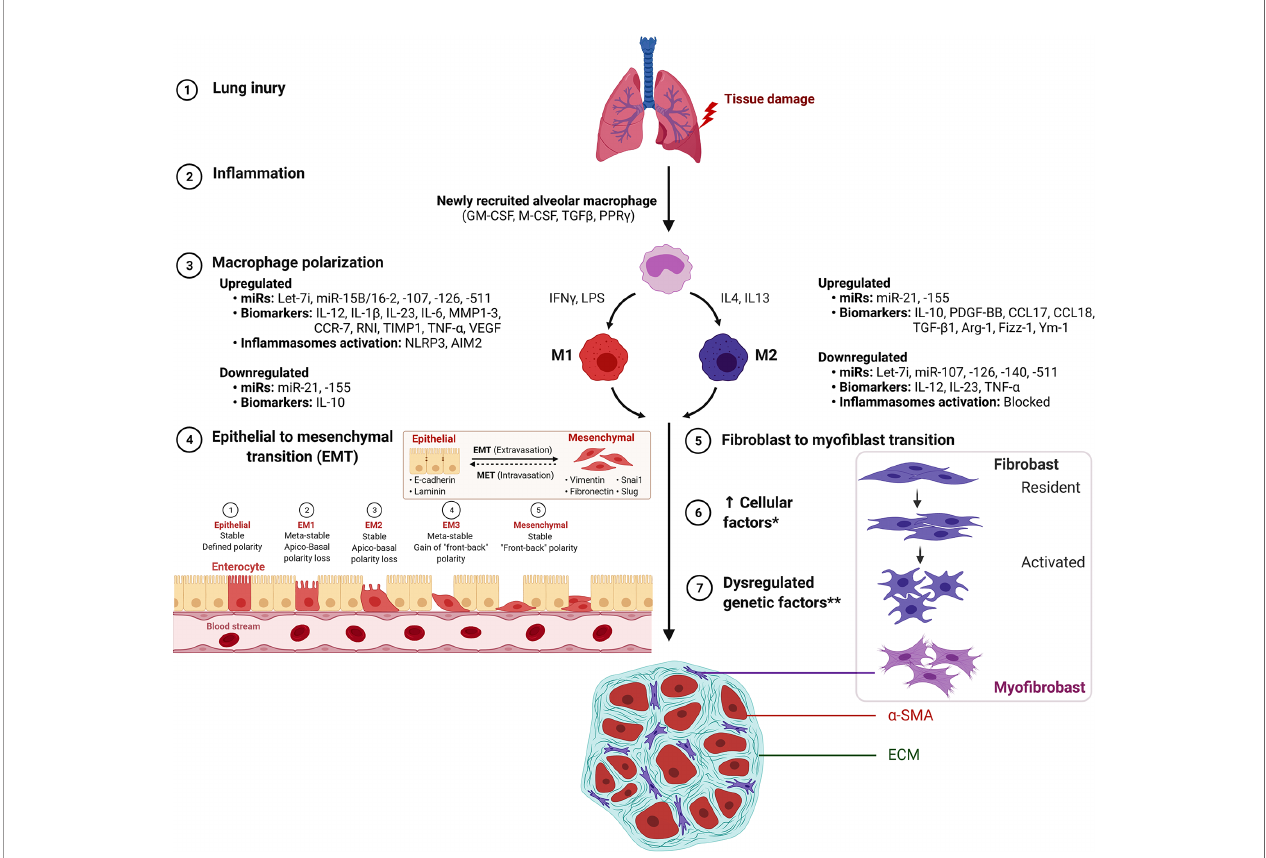
FIGURE 1 | M1 macrophage and M2 macrophage polarization during the development of pulmonary fi brosis. *Increased cellular factors include proliferation, a - smooth muscle actin ( a -SMA), matrix factors, collagen, growth factors and cytokines. **Dysregulated genetic factors include upregulated miR-21 and miR-155 and down-regulated Let-7i, miR-107, mir-126, miR-140 and miR-511. Figure created with BioRender. AIM2 , absent in melanoma 2; ARG1 , Arginase 1; Fizz1/RETNLB , resistin like beta; Ym1/Chil3 , chitinase-like